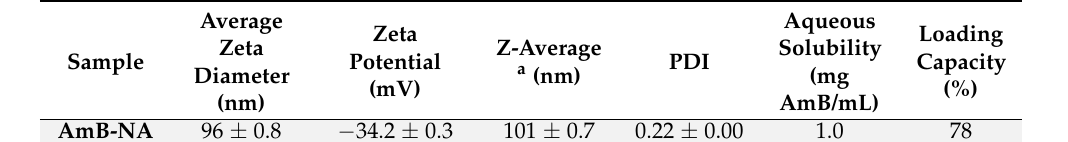
Table 1. Particle size and zeta potential of AmB-NA.